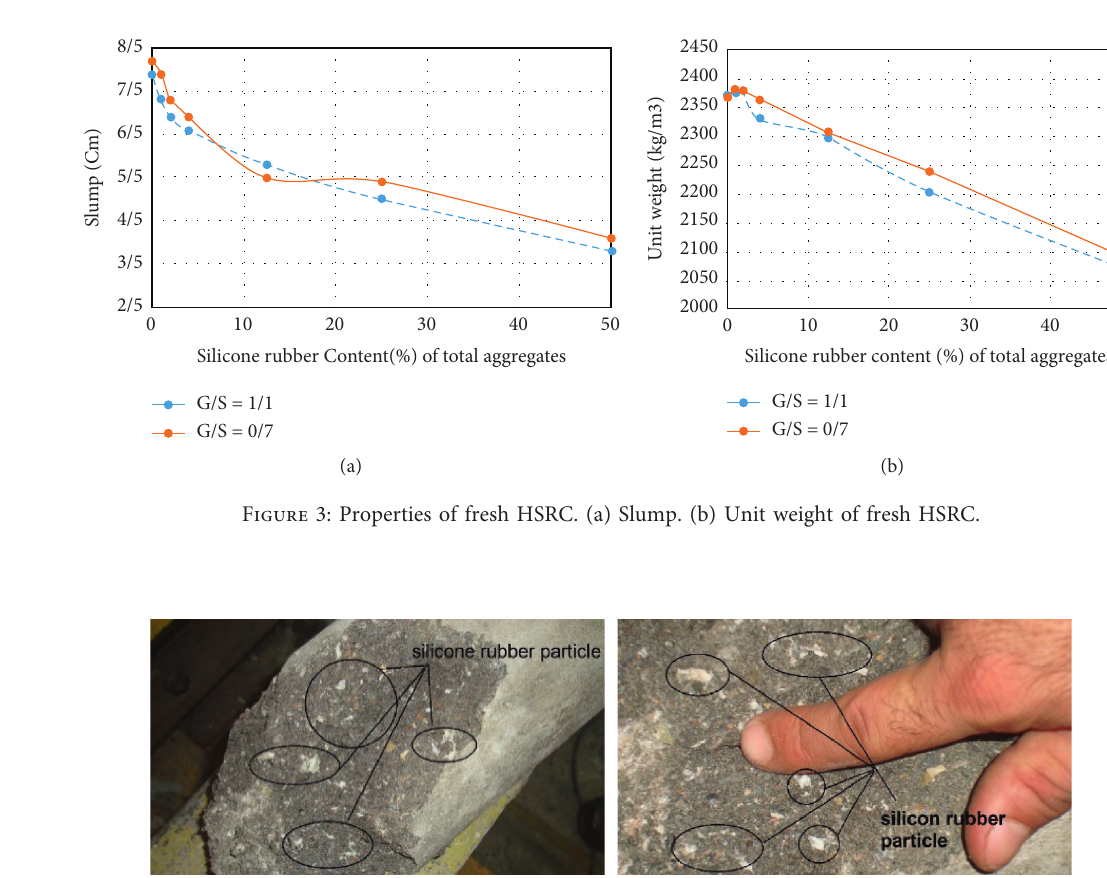
Figure 4: Silicone rubber particles distributed in HSRC specimens.